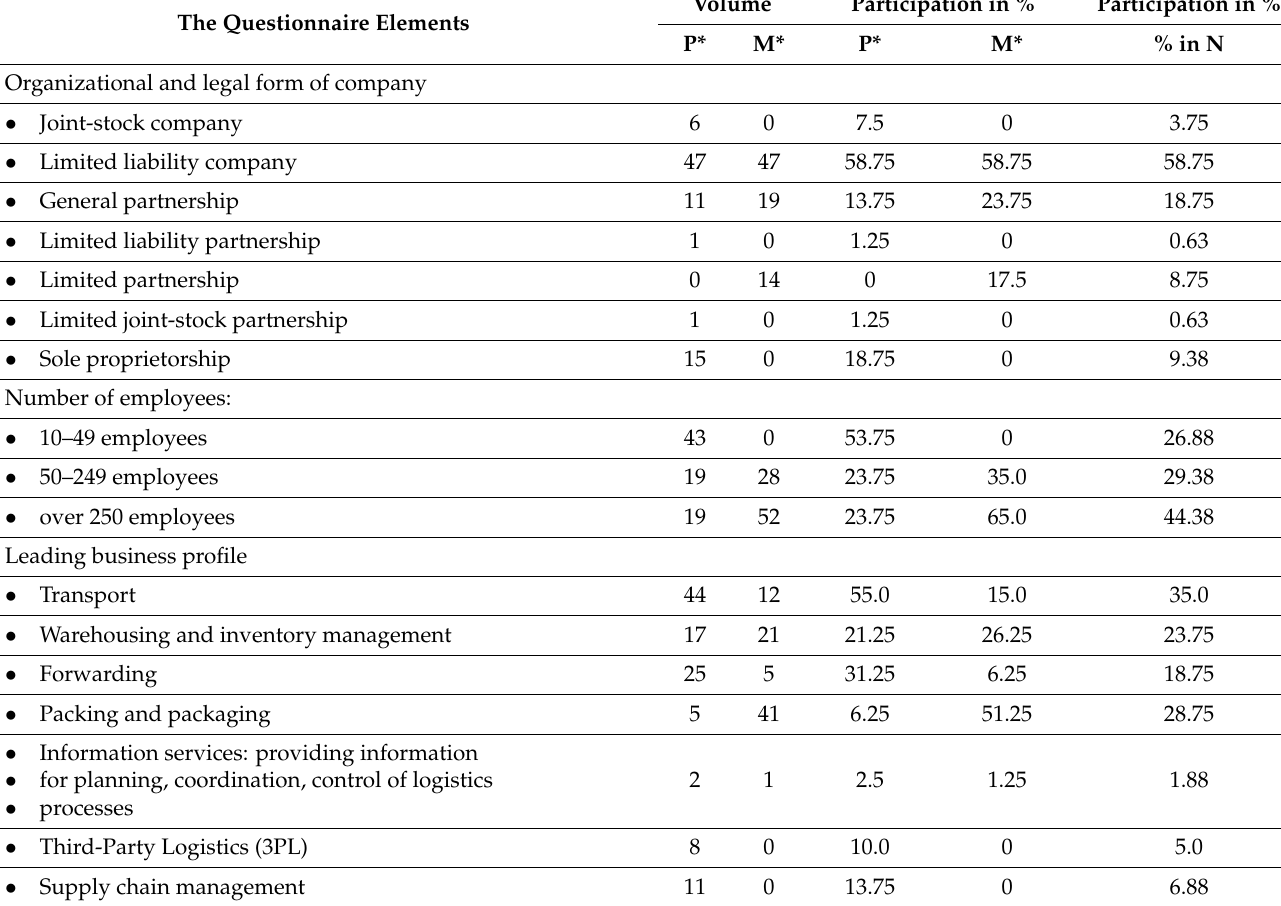
Table 1. Characteristics of the Surveyed Enterprises (N = 160; Poland = 80, Malaysia = 80). The Questionnaire Elements